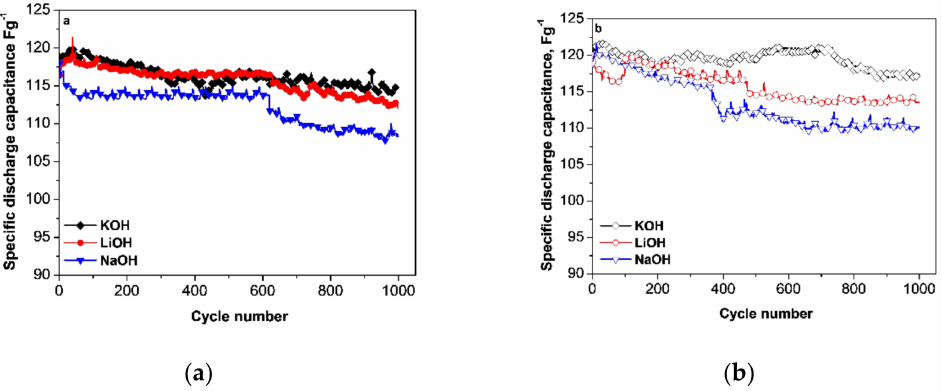
Figure 3. Cycling stability of the discharge capacitance for supercapacitors with YP-50F ( a ) and YP-80F ( b ) electrodes cycled in di ff erent electrolytes at a current rate of 60 mAg −